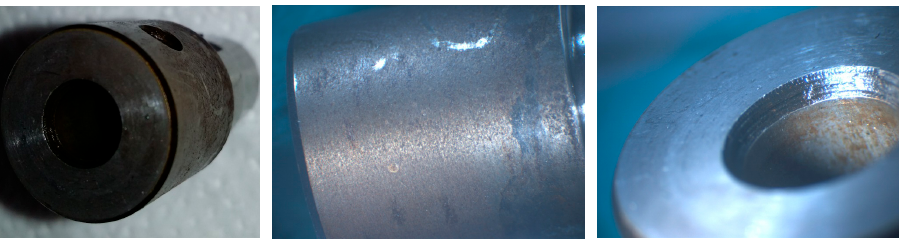
Figure 23. Inside view of the pump housing. Gummy deposits are present.